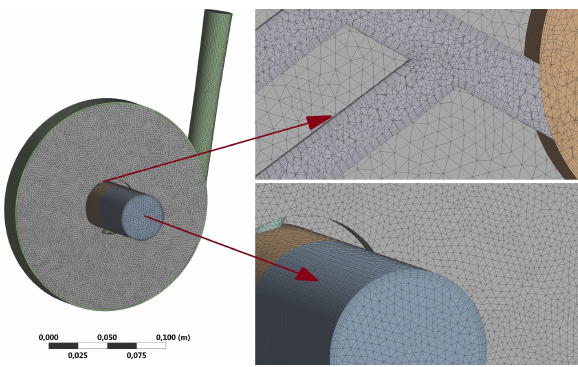
Figure 6: Computational grid with close-up area of high elements concentration